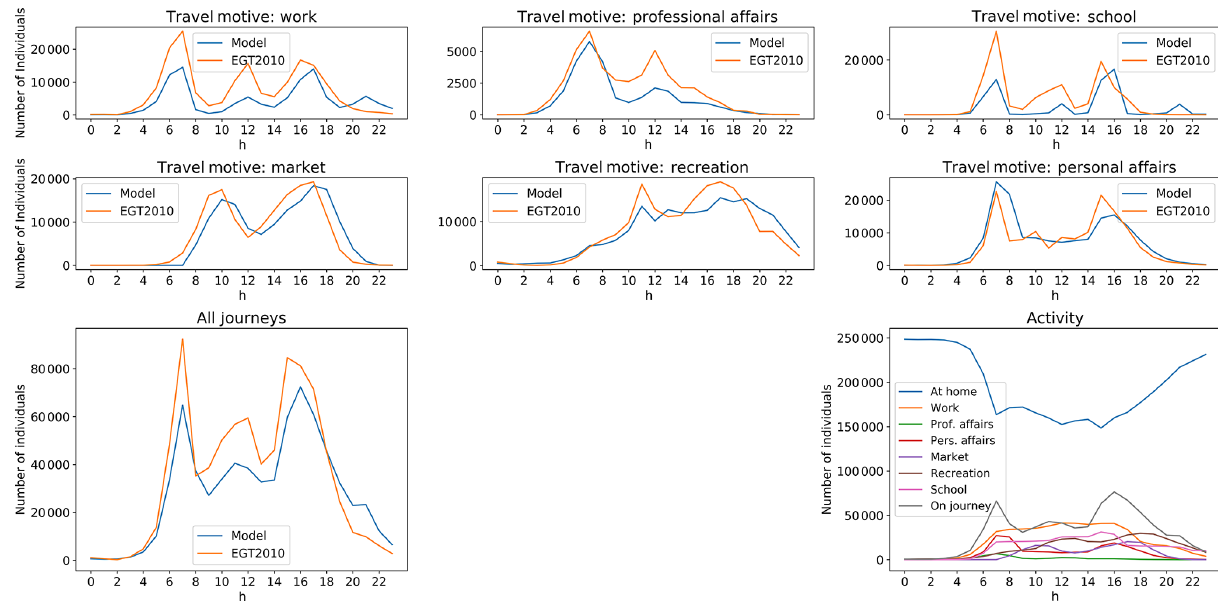
Figure 8. Number of journeys per motive (first and second rows) and total number of journeys with all motives included (bottom left) at each hour. The number of individuals engaged in each activity at each hour of the